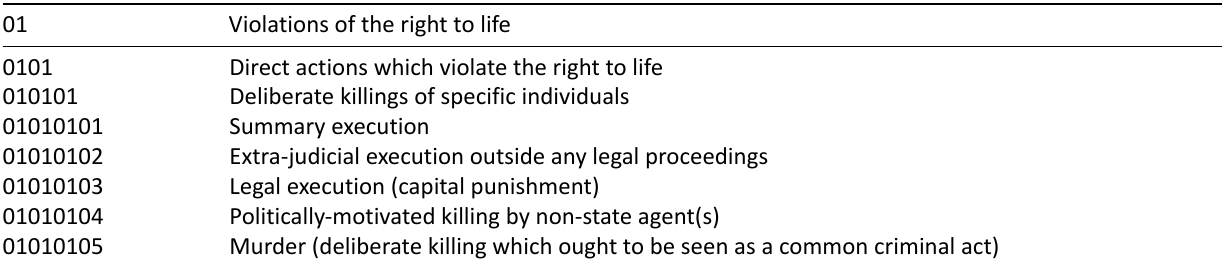
Table 1. Excerpt from HURIDOCS classification scheme for killings, showing code, and description. Violations of the right to